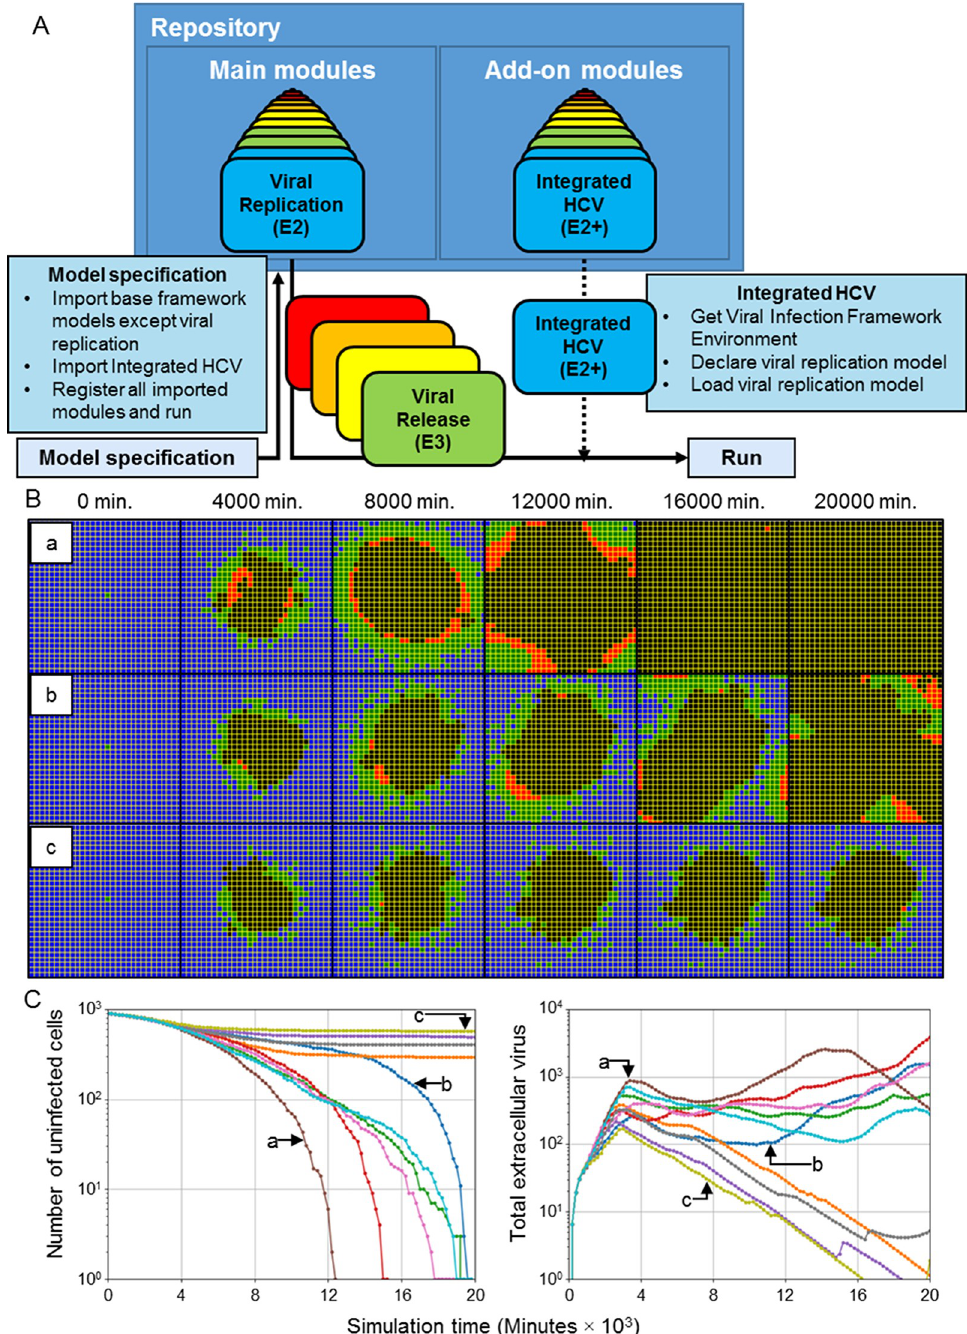
Fig 13. Basic integration of an explicit model of hepatitis C virus subgenomic replication in a spatial context presents stochastic outcomes in ten simulation replicas. (A) Schematic of implementing the integrated HCV model using the available modules described in Models and methods (“Main modules”) and add-on modules libraries hosted in the framework public repository. All main modules are imported except Viral Replication, which is replaced with Integrated HCV. Modules used in a simulation are specified in model specification. The integrated HCV model module is available in the add-on modules library. (B) Distributions of epithelial cells during simulation time for select replicas (labeled “a”, “b” and “c”) using the integrated HCV model. Cell type colors are the same as in Fig 3A. (C) Number of uninfected cells (left) and total extracellular virus (right) during simulation time for ten replicas using the integrated HCV model. Select results shown in (B) are annotated according to replica labels “a”, “b” and “c”.